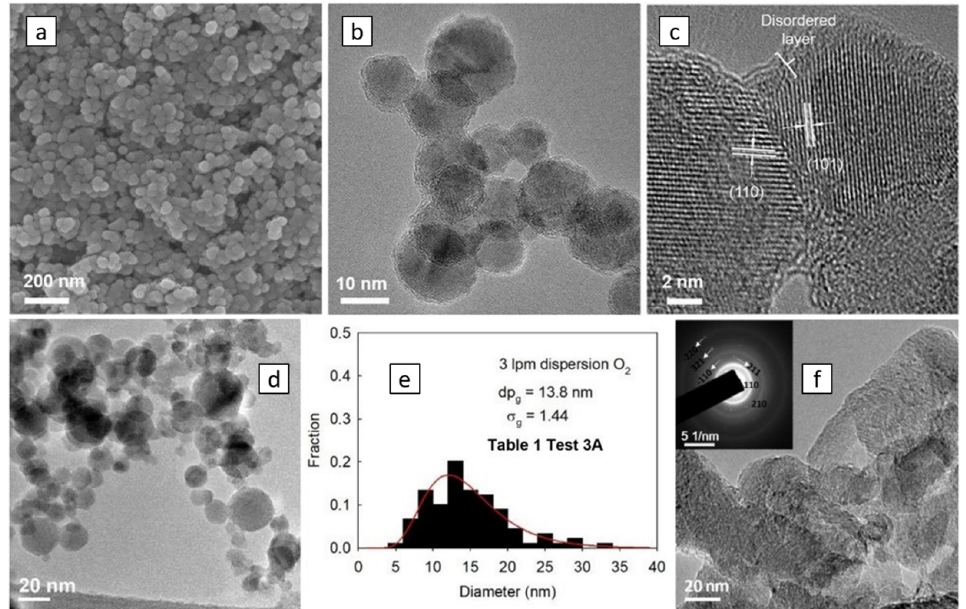
Figure 6. ( a ) FESEM, ( b ) TEM, ( c ) HRTEM techniques, for analysis of morphology of titanium-based NPs [55], reproduced with permission from Wu, S., et al., Small Methods; published by Wiley Online Library, 2020. ( d ) TEM image of flame-synthesized alumina nanoparticles [18], and ( e ) its size distribution, where d pg is mean particle size and σ g is geometric standard deviation [18], Reproduced with permission from Okonkwo, O., et al., Journal of the American Ceramic Society; published by The American Ceramic Society, 2021. ( f ) TEM image of iron-oxide NPs, including SAED pattern at the top-left position for detection of hematite phase [11], reproduced with permission from Hong, H., et al., Proceedings of the Combustion Institute; published by Elsevier, 2019.